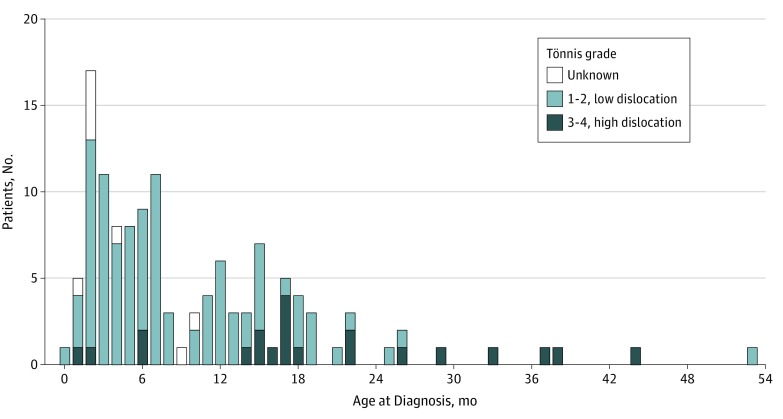
Age at Diagnosis Among 126 Children With Late-Diagnosed Hip Dislocation in SwedenIn bilateral cases, the Tönnis grade of the more severely affected hip is given. Among 8 children, there was no prereduction radiograph.